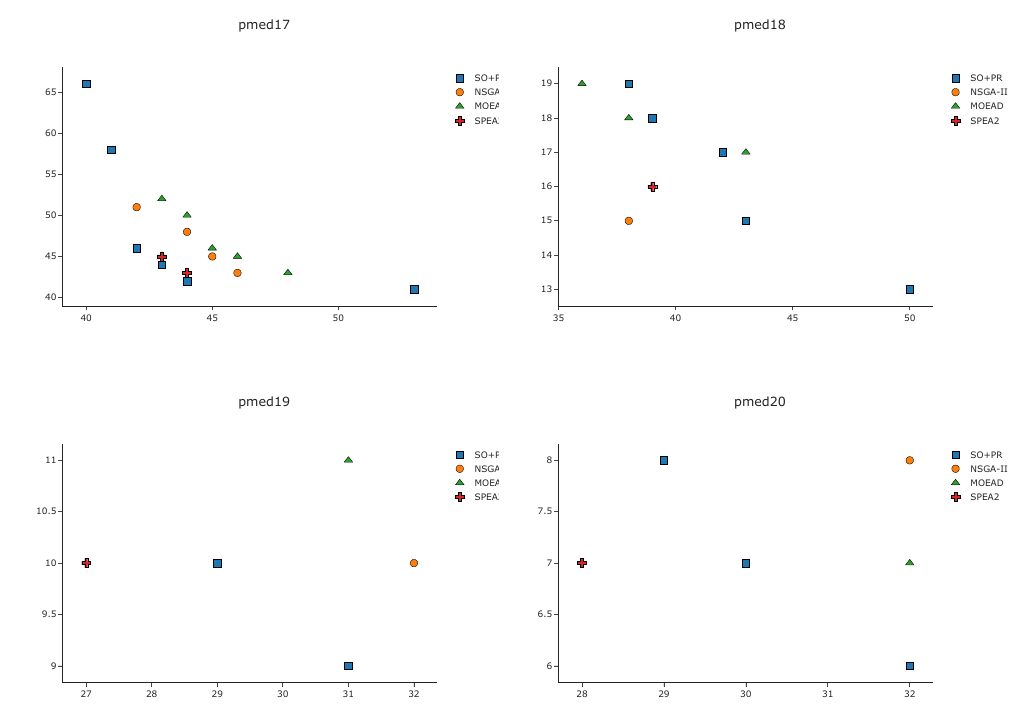
Figure A2. Efficient sets of solutions for M SO+PR , MOEAD , NSGA-II , and SPEA2 for instances pmed11 to pmed20.